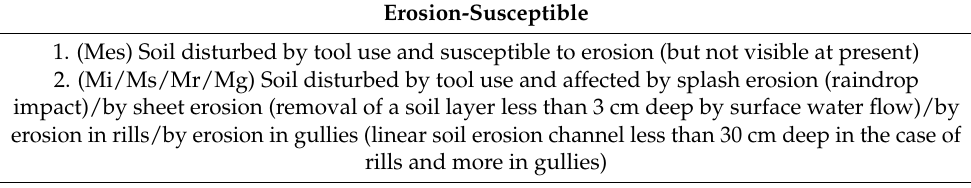
Table 1. Processes and types of erosion affecting soil in the cultivation of maize (adapted from Blanco